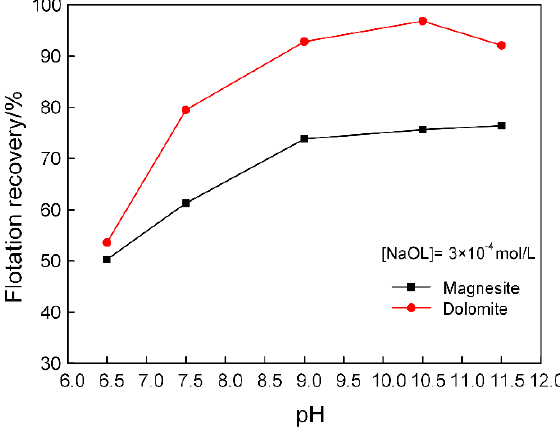
Figure 4. The influence of slurry pH on the flotation separation of magnesite and dolomite. 3.2. Influence of Sodium Phosphate Salts with Different Chain Length on the Flotation Separation of Magnesite and Dolomite